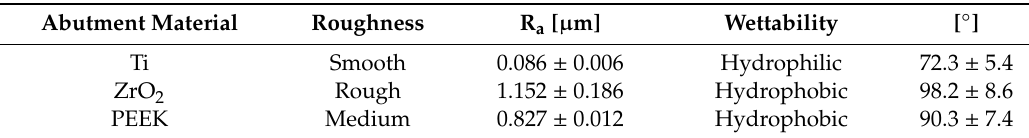
Table 1. Arithmetic average of surface roughness R a (means and standard deviations [ µ m]) and wettability (means and standard deviations [ ◦ ]) of the three tested abutment materials.